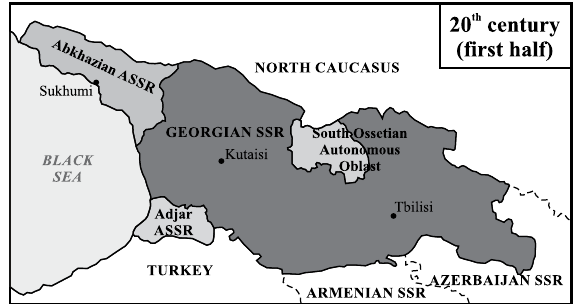
Fig. 5. Stage 5: Georgia as part of the Soviet Union. Source: own elaboration based on Baranowscy